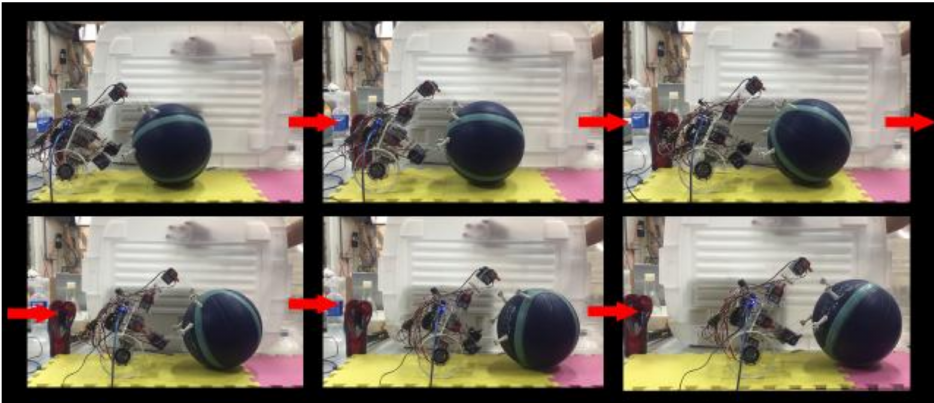
Figure 8. The motion sequence of the dung beetle (second version) robot rolling a